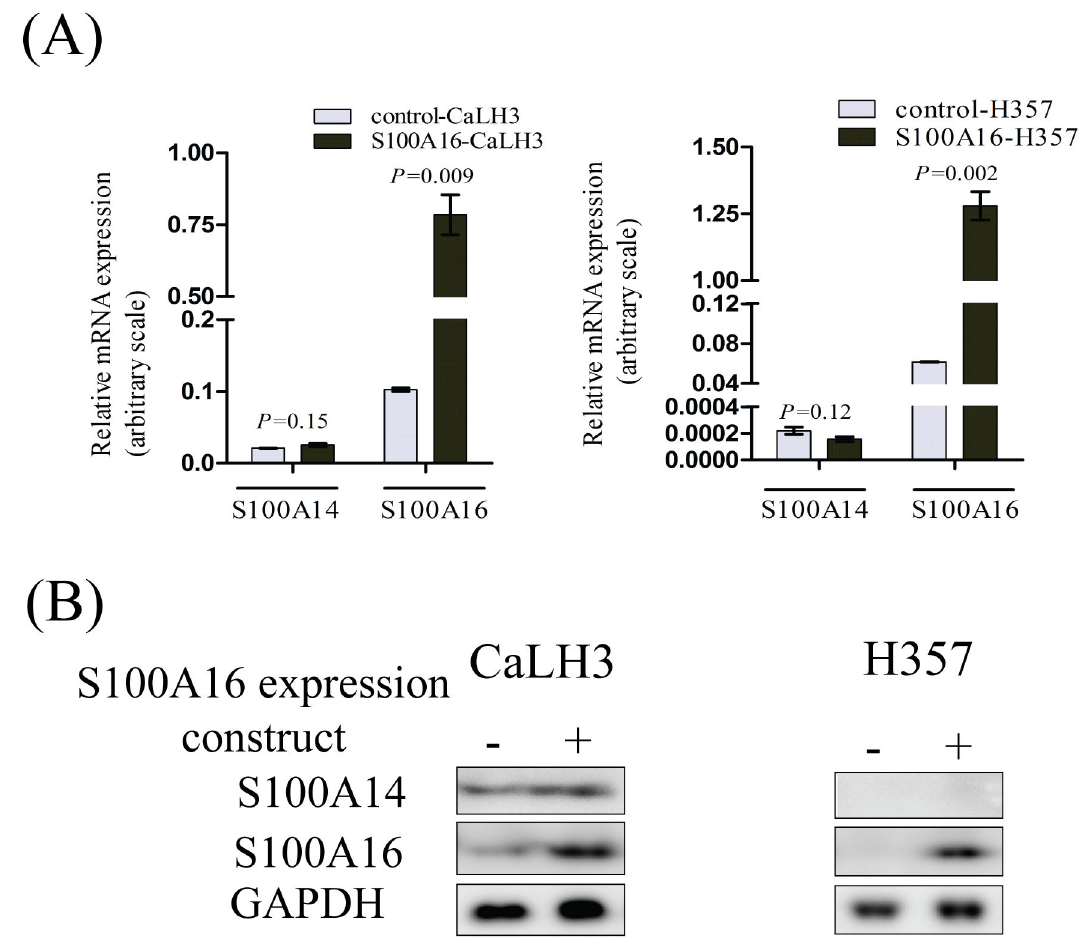
Figure 4. S100A16 regulates neither expression of S100A14 mRNA nor S100A14 protein in human cancer cell-lines. There was no effect in the mRNA (A) or protein (B) expression levels of S100A14 by retroviral mediated over-expression of S100A16 in CaLH3 and H357 cell-lines (-, control construct; +, S100A16 expression construct). S100A14 and S100A16 mRNA expression levels were normalized to GAPDH mRNA expression. Error bars represent SEM of 3 biological replicates done in 3 technical replicates. Student’s- t test (paired) was performed for statistical